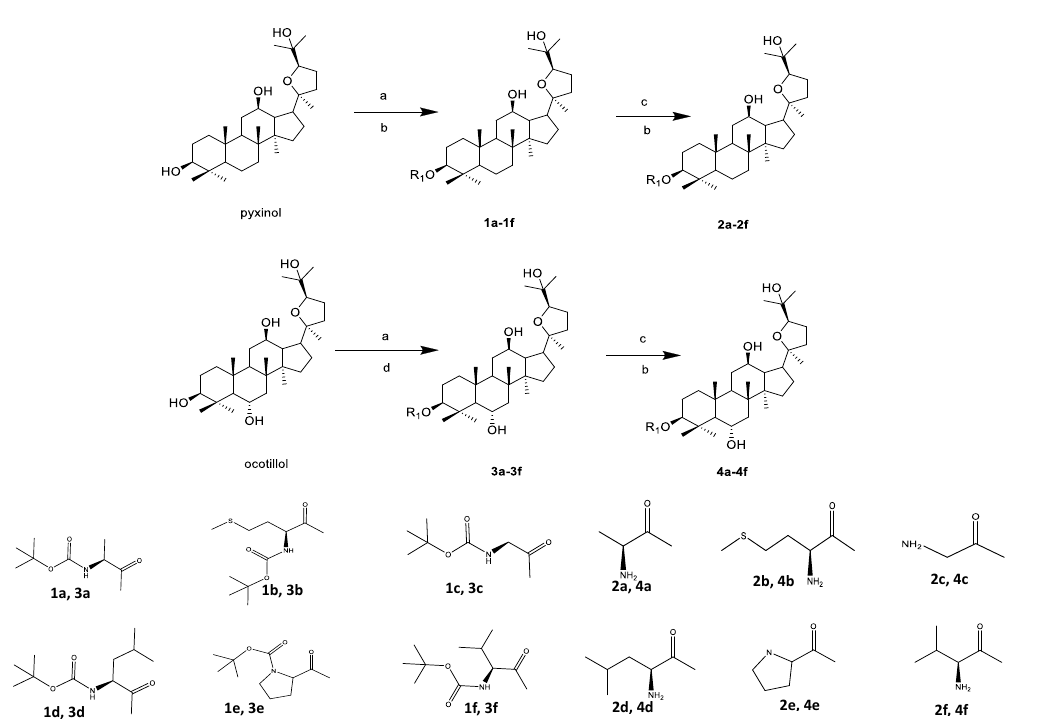
Figure 2. Synthesis of pyxinol and ocotillol derivatives 1a–1f , 2a–2f , 3a–3f , 4a–4f . Reagents and conditions: ( a ) DMAP, EDC, boc-amino acid, r.t. ( b ) dry CH 2 Cl 2 , r.t. ( c ) TFA, r.t. ( d )THF, r.t.